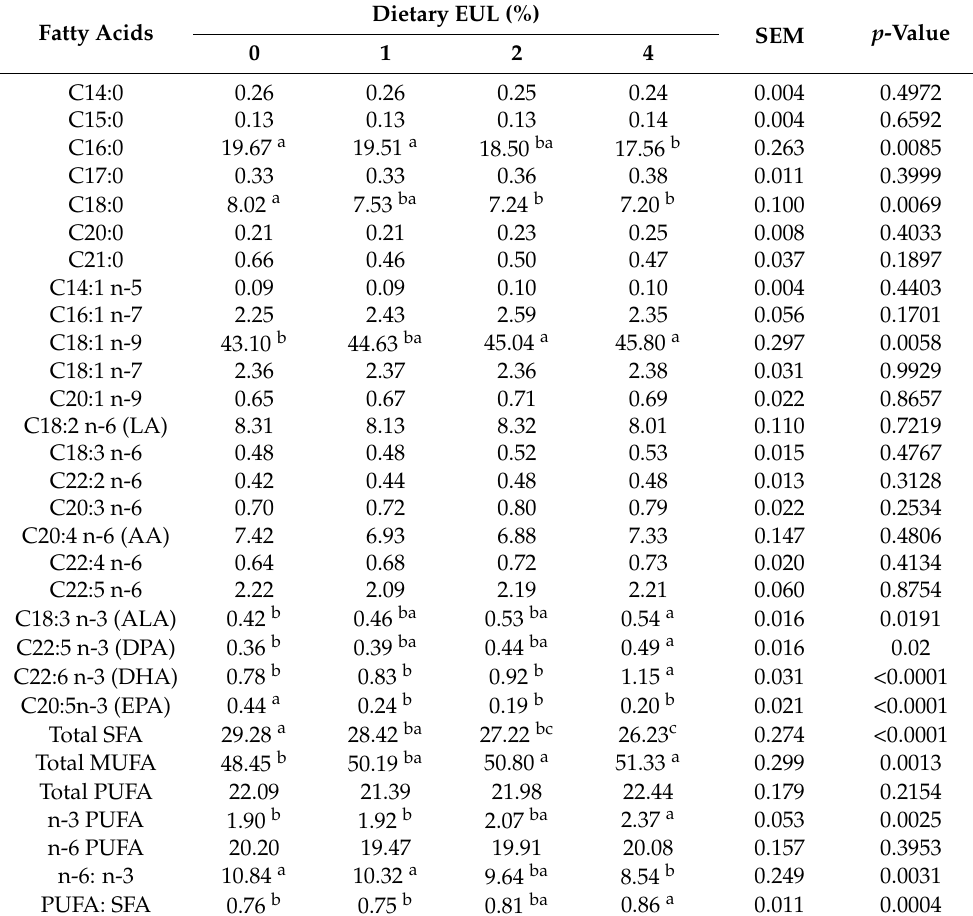
Table 6. Effect of EUL on fatty acids composition (%, w / w ) in yolk after 6 wk of feeding 1 . Fatty